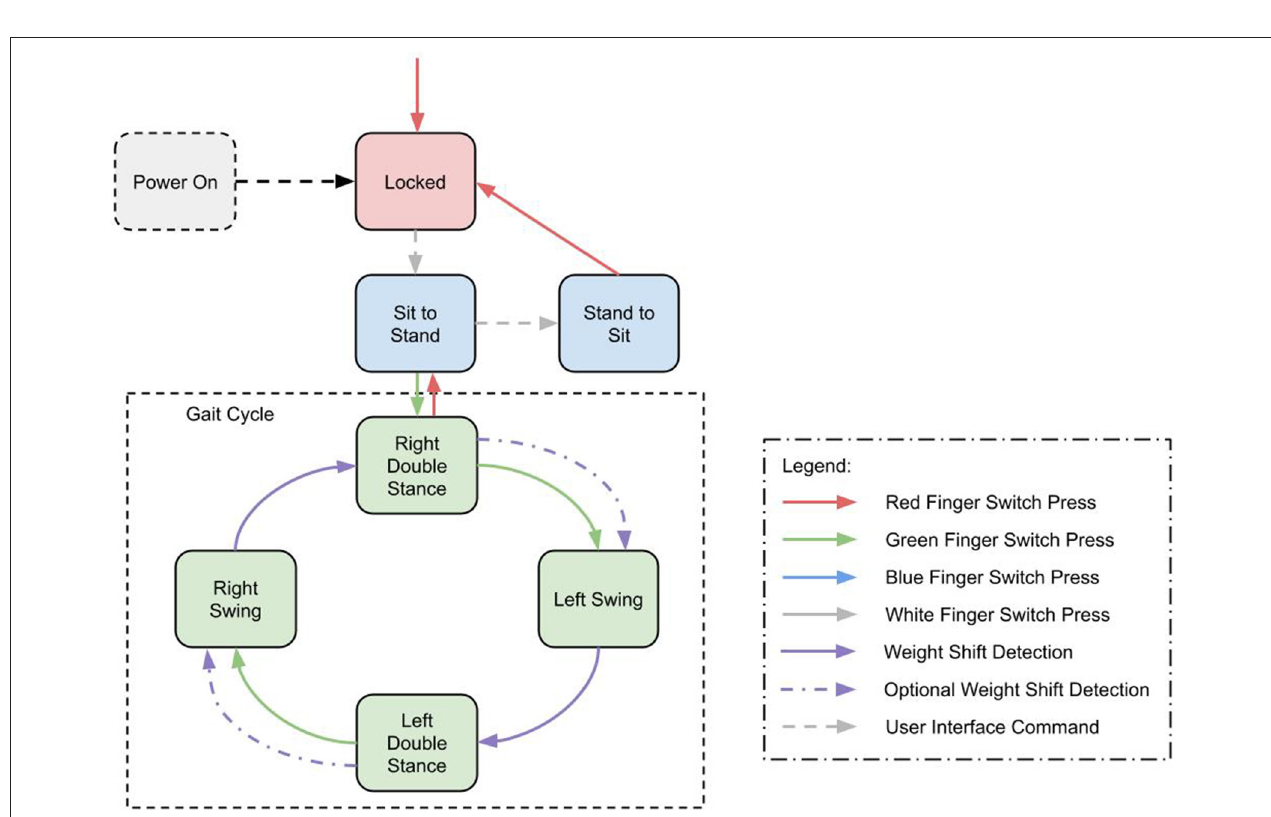
FIGURE 5 | State machine diagram showing transitions between gait states and walk, stand, and sit states.